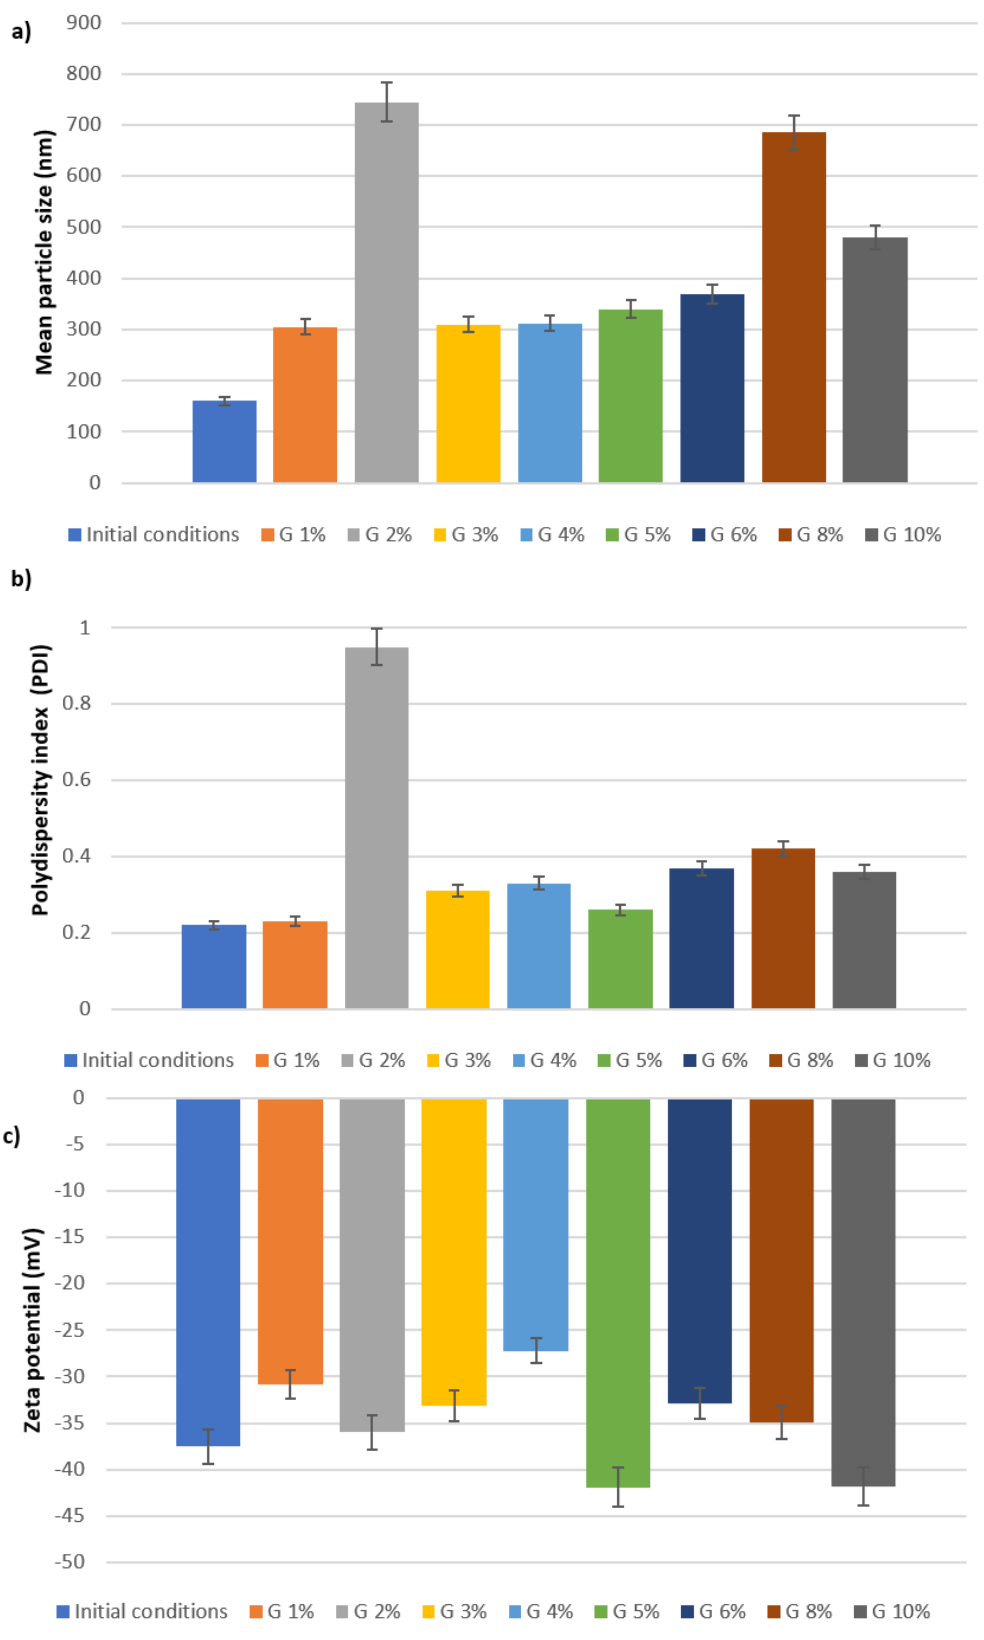
Figure 3. ( a ) Mean particle size (Z-Ave), ( b ) polydispersity index (PDI), and ( c ) zeta potential of SLNs using increasing concentrations of